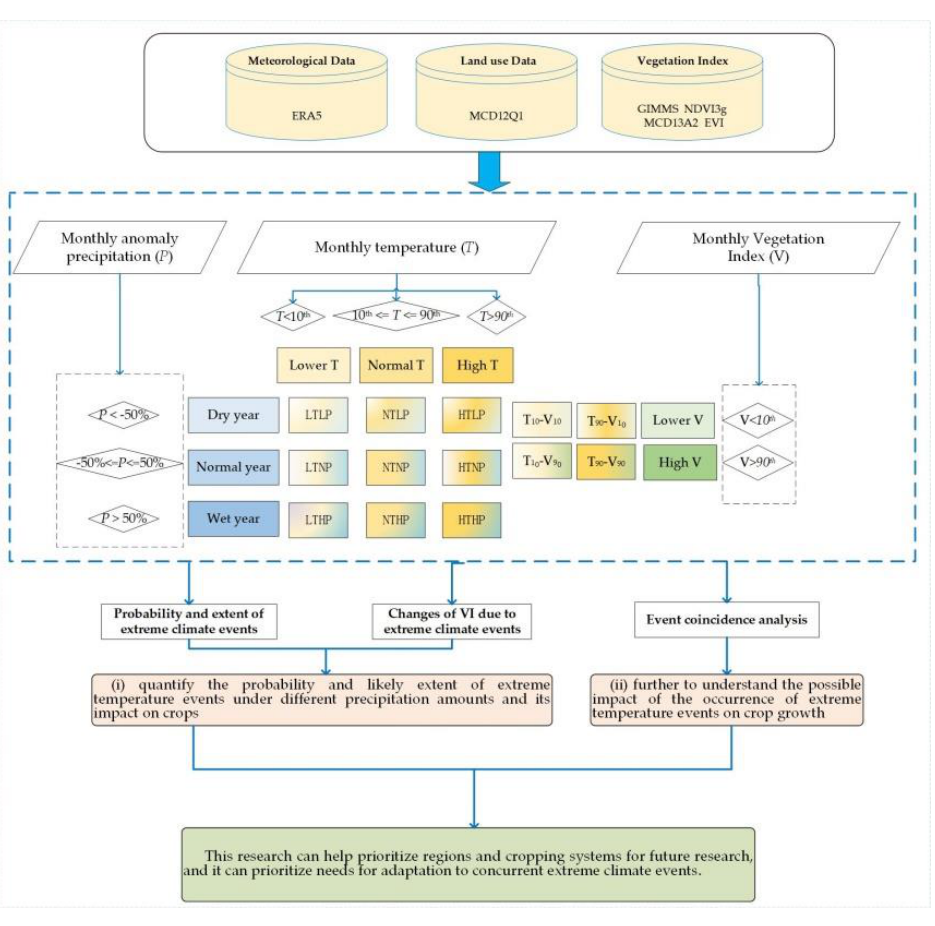
Figure 2. The framework to analyze the impacts of extreme temperature and precipitation on crops in Bangladesh, India and Myanmar.